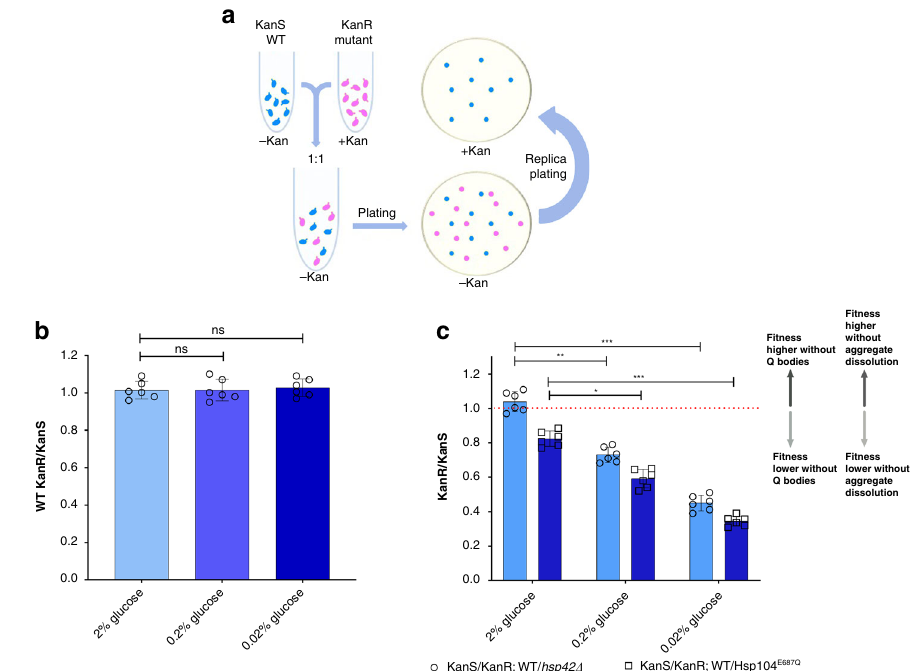
Fig. 7 Protein compartmentalization during metabolic stress confers fi tness advantage. a Scheme of the competition assay. In the mid-exponential phase the cells were pelleted, and then resuspended in YPD medium with 0.2% and 0.02% glucose for 90 min. Equal representation of the cells was ensured. This was followed by plating the serial dilutions on YPD-agar plates without kanamycin, and dilutions with between 50 and 200 colonies were replica plated on YPD-agar plates with kanamycin (50 µ g/mL). Colonies were counted on both types of plates, and the ratio of kanamycin-resistant (mutant) to kanamycin-sensitive (WT) colonies was calculated. Following the same centrifugation procedure, the cells were transferred back into YPD medium with 2% glucose and grown for 24 h counting from the moment of initial dilution. In parallel, a series of the same samples was continuously kept in 2% glucose for control. The same treatment was applied to the control cells to take into account the potential effects of the centrifugation on cell survival. KanS stands for a kanamycin-sensitive phenotype; KanR stands for a kanamycin-resistant phenotype. b Competitive fi tness of the WT strain is unaffected by the kanamycin-resistant phenotype in optimal conditions, and during the starvation. c Competitive fi tness of yeast cells is strongly decreased in the hsp42 Δ and Hsp104 E687Q mutant in both 0.2% and 0.02% glucose. Bar height represents mean ± SD from six separate cultures, each performed in triplicate. The mean of three technical replicates for six biological replicates is displayed as single data points. *** p < 0.001; ** p < 0.01; * p < 0.05 (one-way ANOVA plus Tukey post